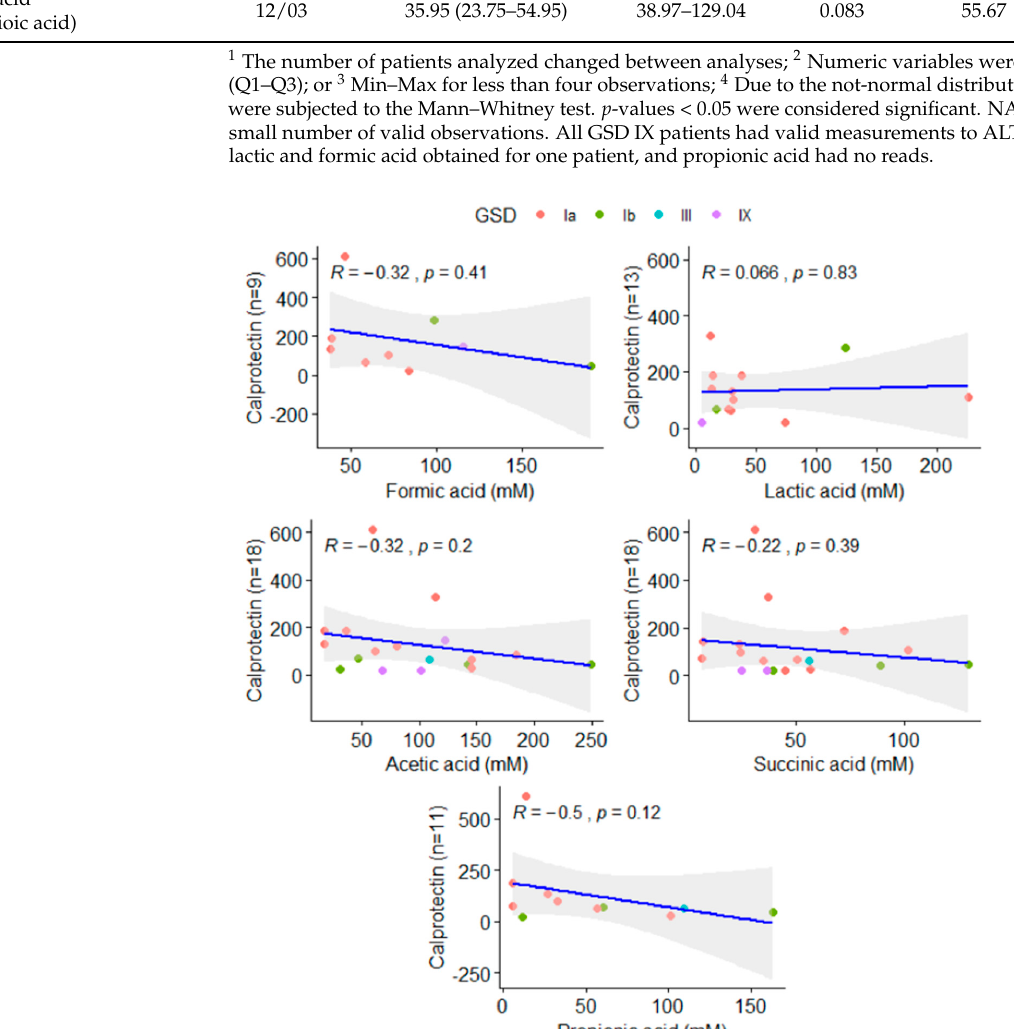
Table 2. Description of clinical parameters and measured metabolites among GSD types.